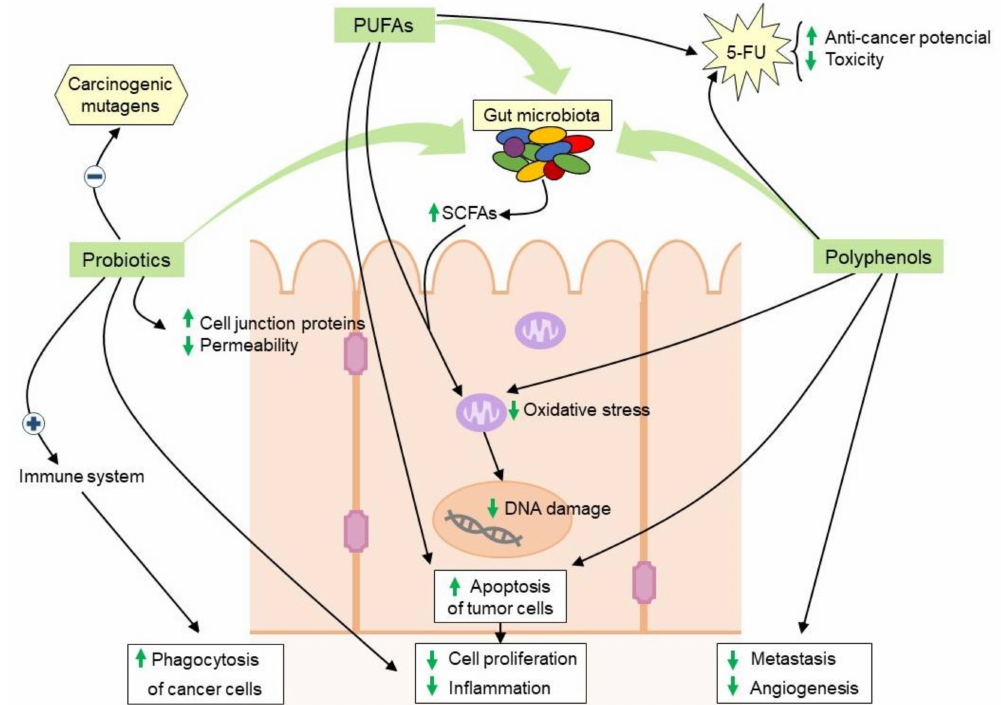
Figure 2. Beneficial e ff ects of dietary supplementation with PUFAs, polyphenols and probiotics on the intestinal microbiota and colon cells for the reduction of CRC risk or to enhance the response to cancer therapy when are used as adjuvant to conventional treatment. PUFAs: omega-3 polyunsaturated fatty acids; 5-FU: 5-fluorouracil; SCFAs: short-chain fatty